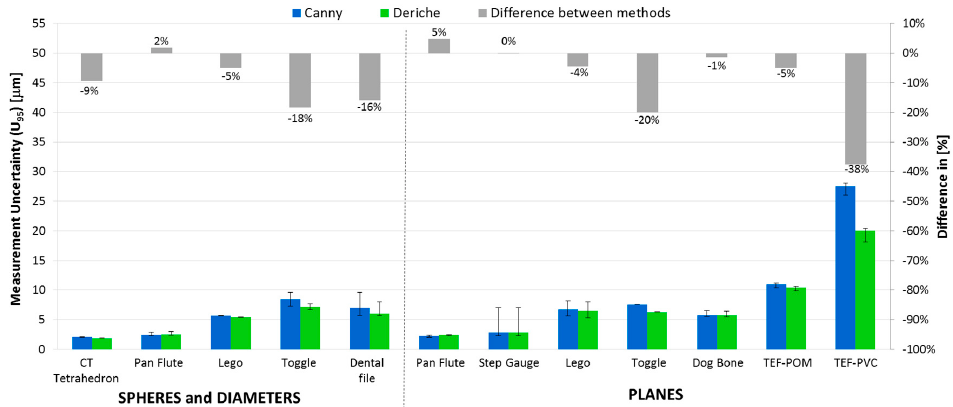
Figure 12. Expanded average measurement uncertainty ( U 95 ) for the Canny-based method (blue bars) and Deriche-based method (green bars), differences between them (grey bars), and maximum and minimum measurement uncertainties (error bars) of all the part dimensions for each item by dimension type.